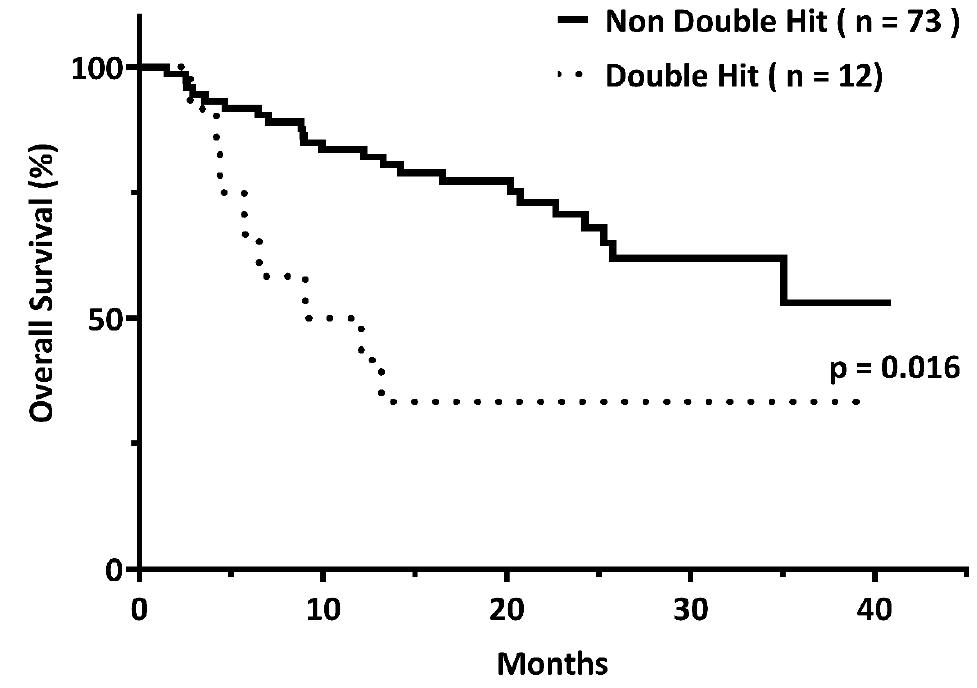
Figure 1. The three-year overall survival rates among patients with ( n = 12) and without ( n = 73) double hit (DH) genetics were 33.3% and 52.2%, respectively ( p = 0.016).